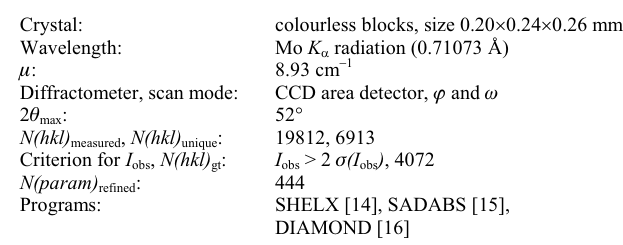
Table 1. Data collection and